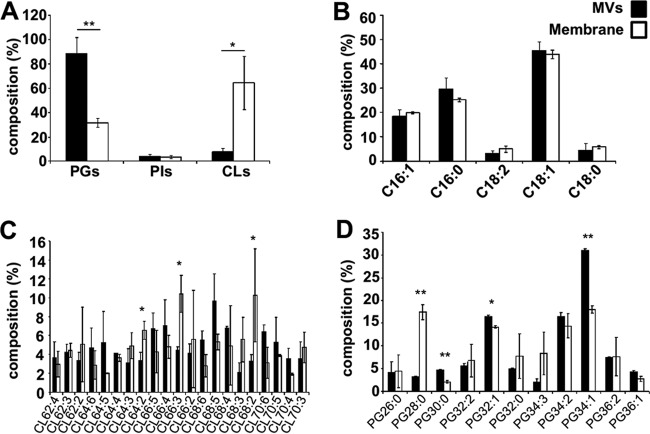
PG is the dominant anionic phospholipid in GAS MVs. (A) Characterization of anionic phospholipids phosphatidylglycerol (PG), phosphatidylinositol (PI), and cardiolipin (CL) in ISS3348 MVs and membranes. (B) General distribution of GAS medium-chain fatty acids (FAs) in MVs and membranes. (C and D) Comparison of GAS MVs and membrane FA saturation level and arrangement in anionic lipids CL and PG. The results presented are means ± standard deviations (SD) from 3 experiments. Asterisks indicate statistical significance by one-way analysis of variance (ANOVA) with Tukey’s post hoc test: *, P < 0.05; **, P < 0.01.